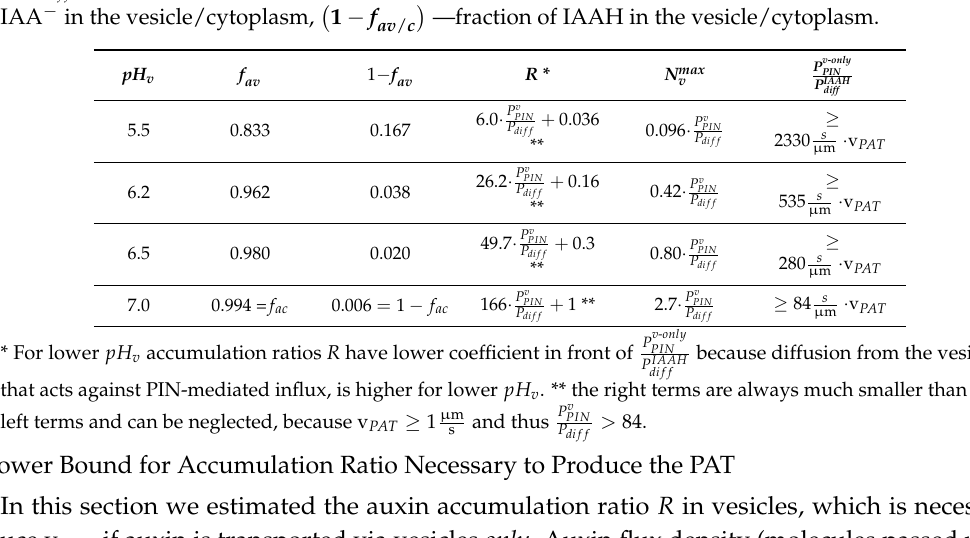
Table 3. Dependence of the accumulation ratio R (Equation (18)) and maximum number of molecules in the vesicle N max v (Equation (15)) on pH in the vesicle. The last column provides the lower bounds v - only PIN for P P